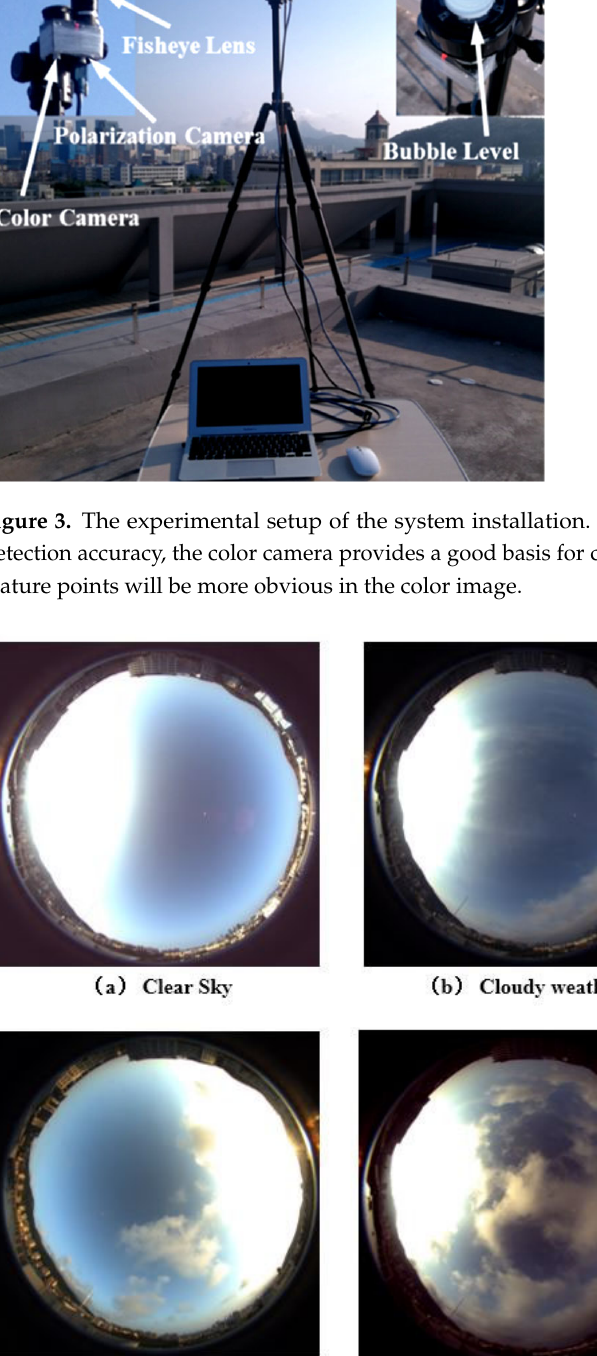
Figure 4. Real shot of the sky under different cloud conditions. When the sun is clearly visible in the sky, about one-third of the cloud information in the image will be lost (considering the distortion of the fisheye lens, this proportion will only be greater in reality). To solve this problem, traditional methods need to rely on sun-blocking devices, while we use HDR image fusion to incomplete the missing image details.